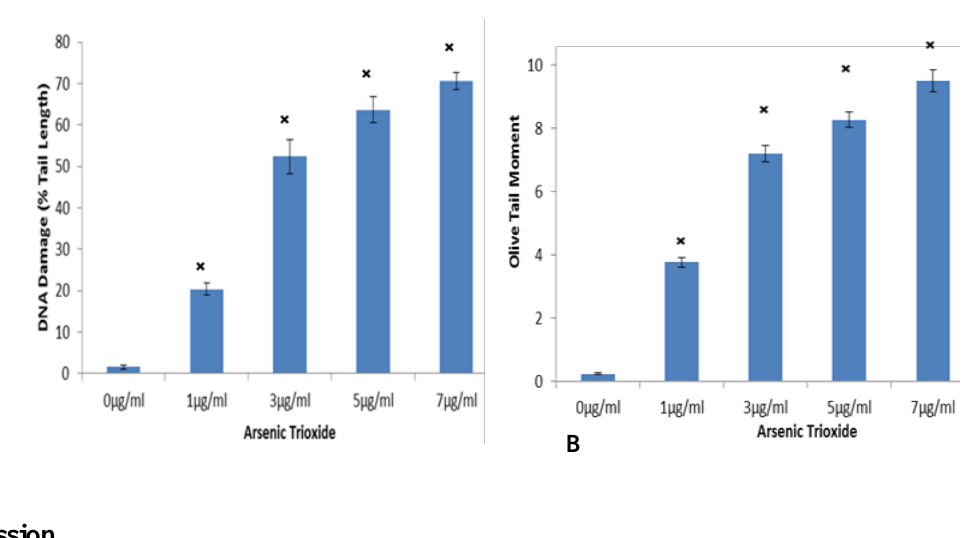
Figure 4. Tail Length and Olive tail moment after 24 hour of ATO exposure to IPS cells. ( A ) The tail length increased as dose increased showing an increase in DNA damage. ( B ) Olive tail moment which shows the smallest detectable size of migrating DNA (reflected in tail length), these results were consistent with tail length and the comet representative. All p -values <0.05 were considered to be significant as denoted by ×